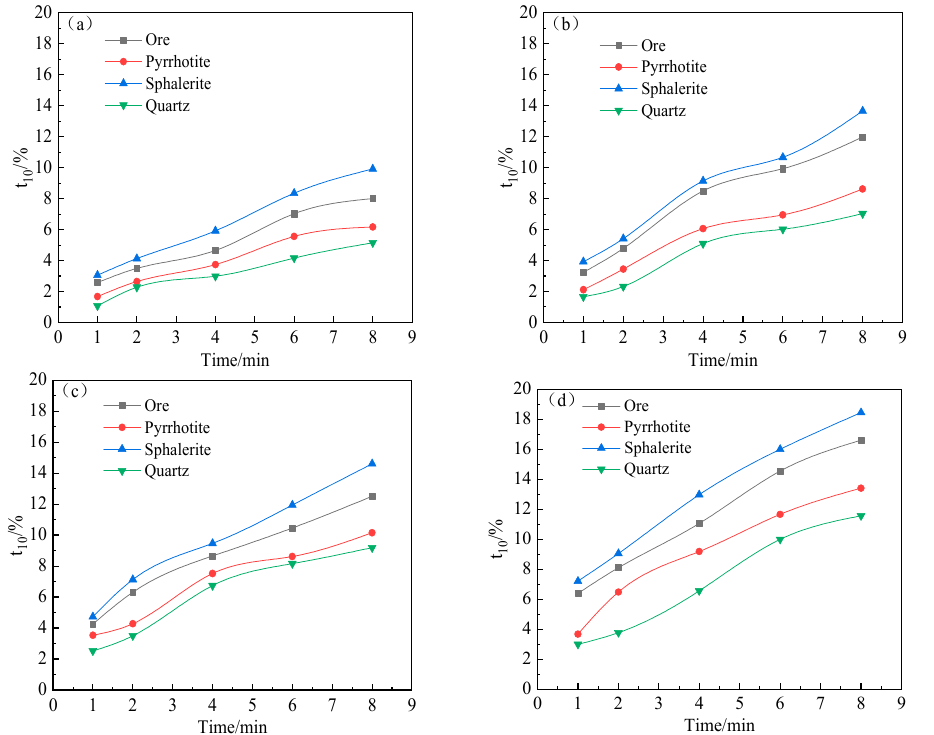
Figure 8. Comparison diagrams of the relationship between the t 10 of grinding products and grinding time for ore and component minerals ( a ) − 4.75 + 3.36 mm, ( b ) − 3.35 + 2.36 mm, ( c ) − 2.36 + 1.70 mm, ( d ) − 1.70 + 1.18 mm.